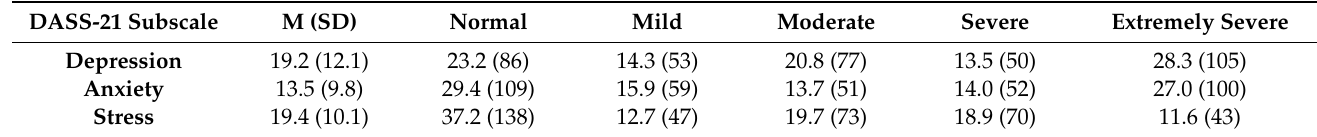
Table 3. Proportion (%) of participants scoring in DASS-21 severity categories ( n =